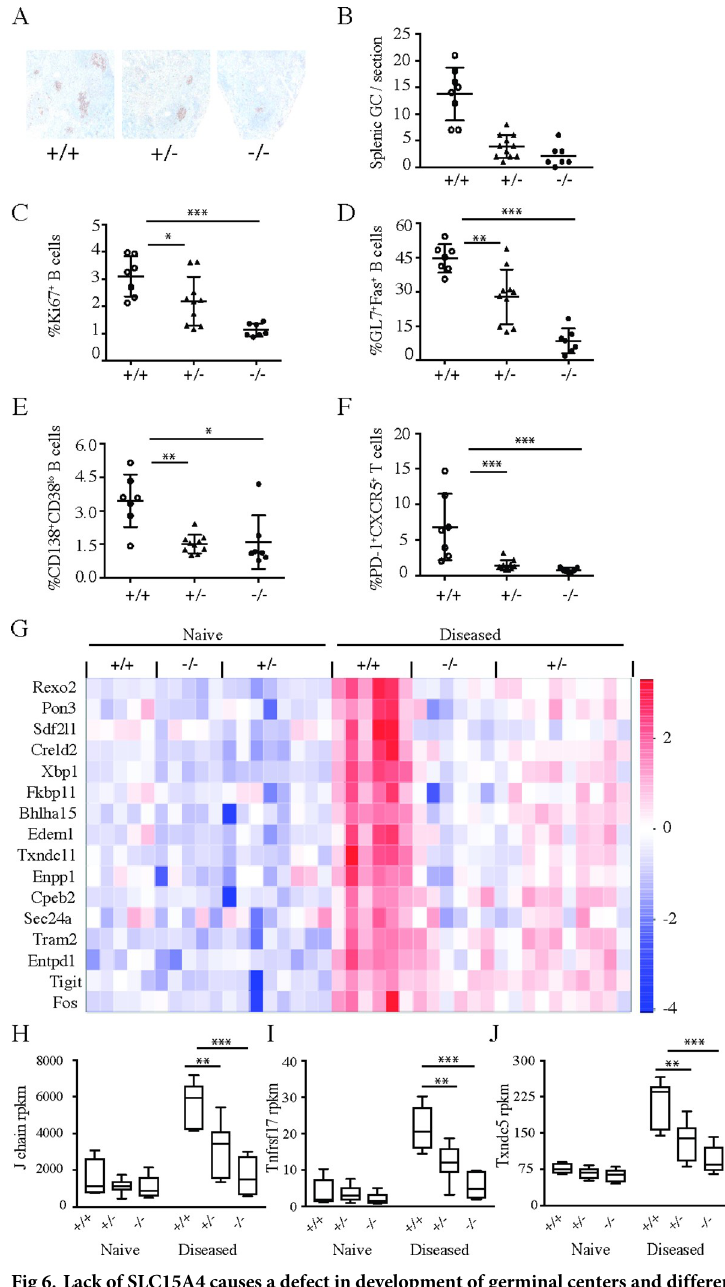
Fig 6. Lack of SLC15A4 causes a defect in development of germinal centers and differentiation of antibody secreting cells in NZB/W F1 mice. NZB/W F1 slc15a4 +/+ , slc15a4 +/- , and slc15a4 -/- mice were euthanized at the age of 36 weeks. Development of splenic germinal centers was assessed by PNA-lectin staining and immunohistochemistry in formalin fixed spleens (A) and quantified for all mice in the experiment (B). The phenotype of splenic lymphocyte population from individual mice was determined by flow cytometry and expressed as mean ± SD. Symbols represent individual mice and depict frequencies of proliferating B cells (B220 + Ki67 + ) (C), germinal center B cells (GL7 + Fas + ) (D), splenic plasma cells (CD138 + CD38 lo ) (E) and follicular T helper cells (PD1 + CXCR5 + ) (F). Gene expression changes in spleens were assessed by RNA sequencing. Specifically, selected transcripts associated with plasma cell generation and induced upon disease development (log2-fold change > 2, p < 0.05) were significantly reduced in heterozygous and slc15a4 -/- mice (G). Representative box plots of genes expressed by antibody secreting cells including J chain (H), tnfrsf17 (I) and txndc5 (J) are shown as mean ± SD. Comparisons were made between wildtype group and knockouts or heterozygous groups � p < 0.05, �� p < 0.005, ��� p < 0.0005, N = 7 per group.